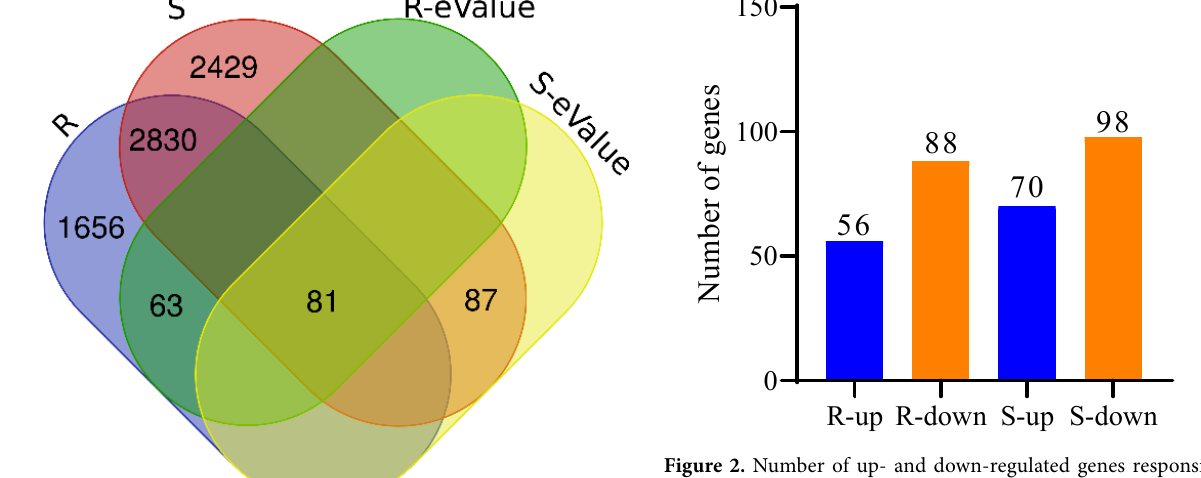
Figure 2. Number of up- and down-regulated genes responsive to powdery mildew in susceptible and resistant genotypes.